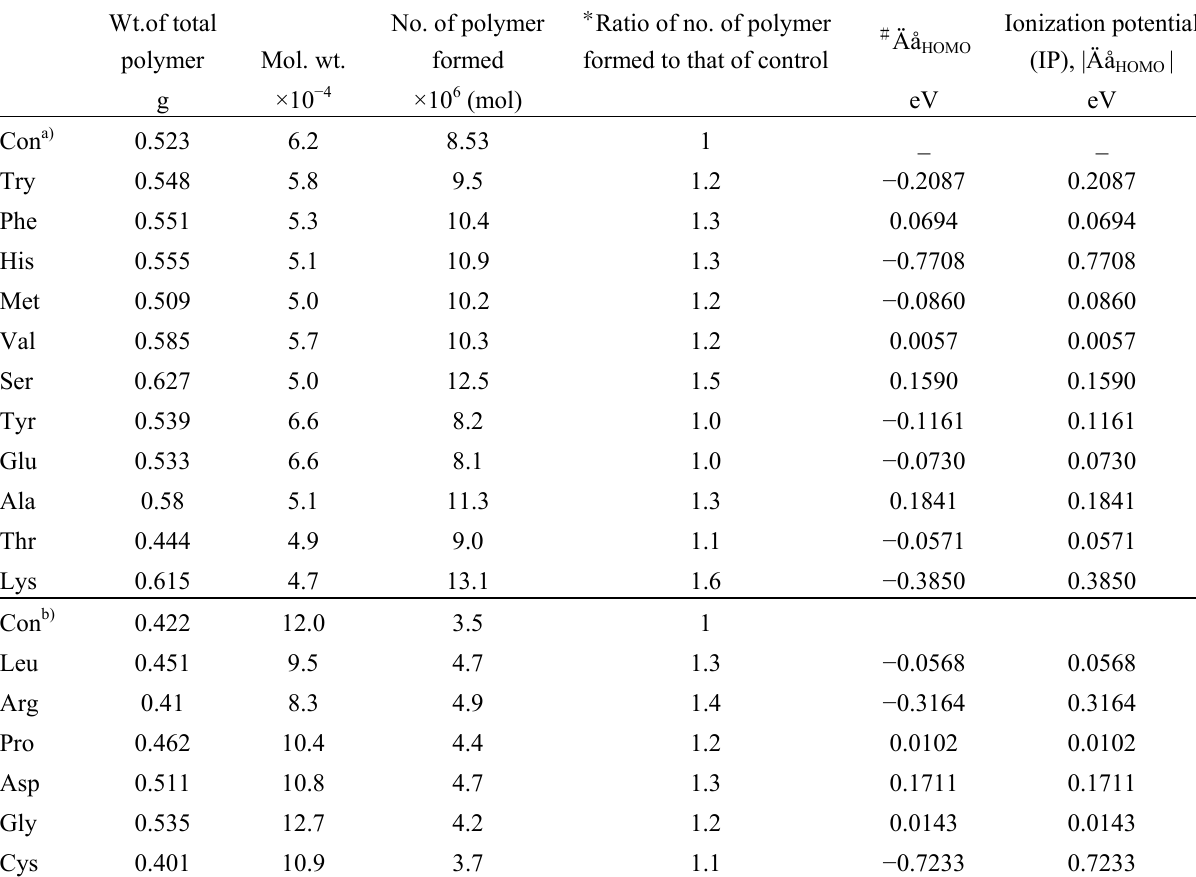
Table 1. Co-catalytic effects of L-amino acid on polymerizations of methyl methacrylate by tri- n -butylborane in the presence of water. Wt.of